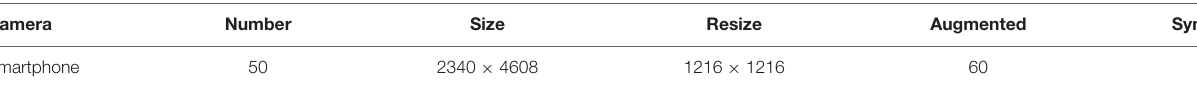
FIGURE 4 | Apples detected from the updated model. TABLE 2 | Image number, sources, and augmentation of pear